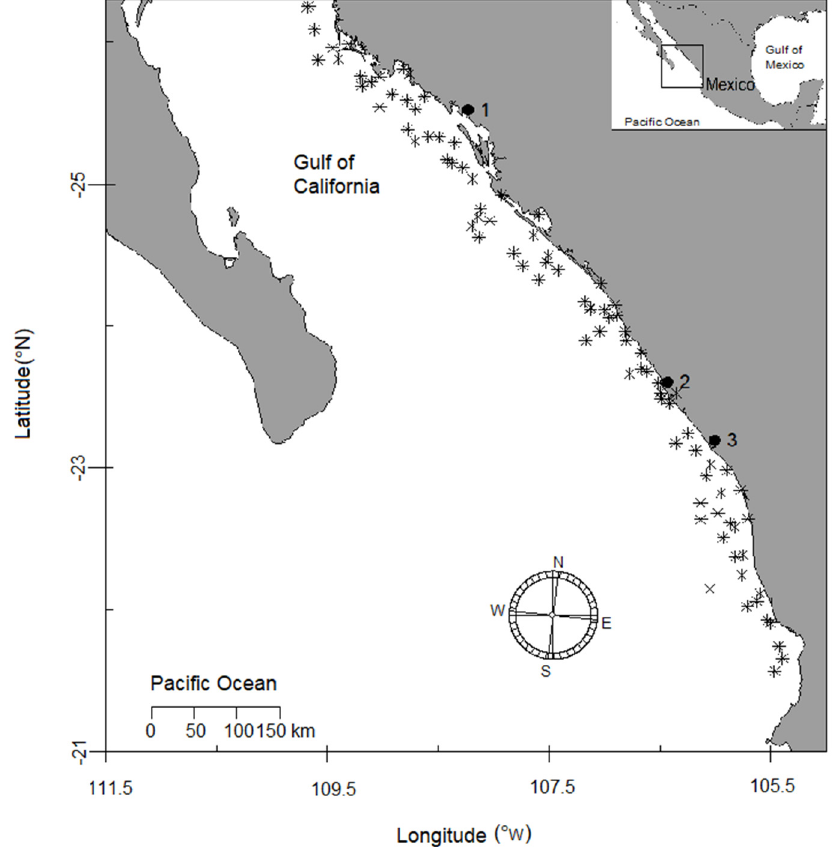
Figure 1. Area of the study showing the position of research trawls (asterisks), and the small-scale fishery grounds where samples were obtained (dots; 1. La Reforma, 2. Mazatl á n, and 3. Chametla). Analyzed specimens were dissected, sex identified, and total length ( TL ) was measured to the nearest cm. The mean TL for males and females and their standard deviation were calculated. The gutted weight and the weight of gonads and liver were obtained to the nearest 0.1 g. The proportion of females to males in the total sampling was estimated and compared to a proportion 1:1 with a Chi-squared test ( χ 2 ).